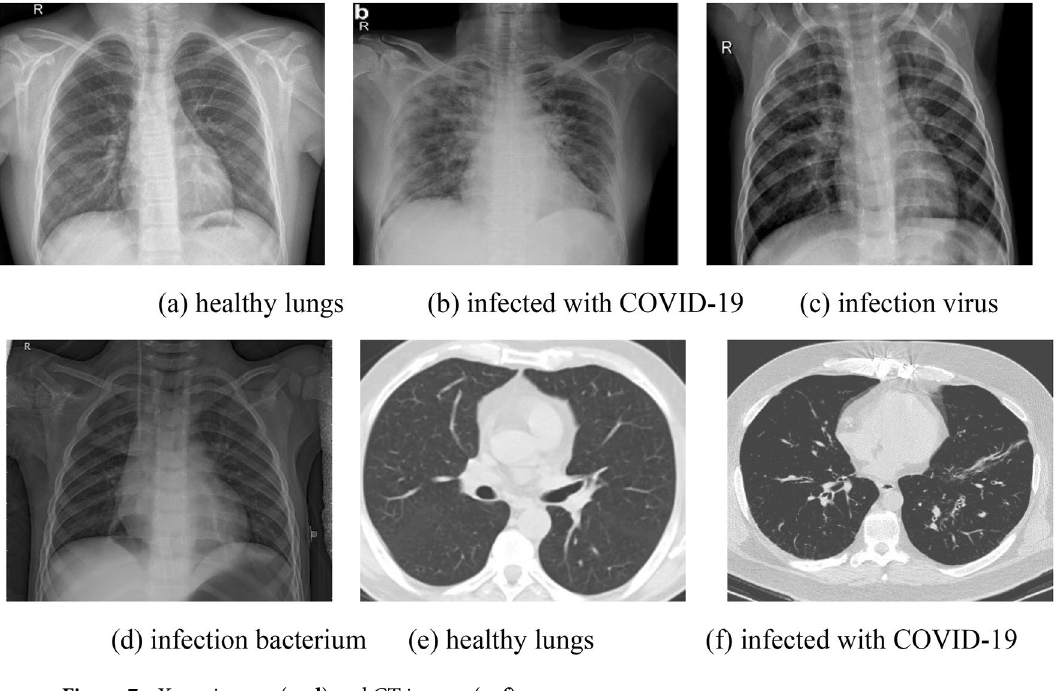
Figure 7. X-ray images ( a – d ) and CT images ( e – f ).